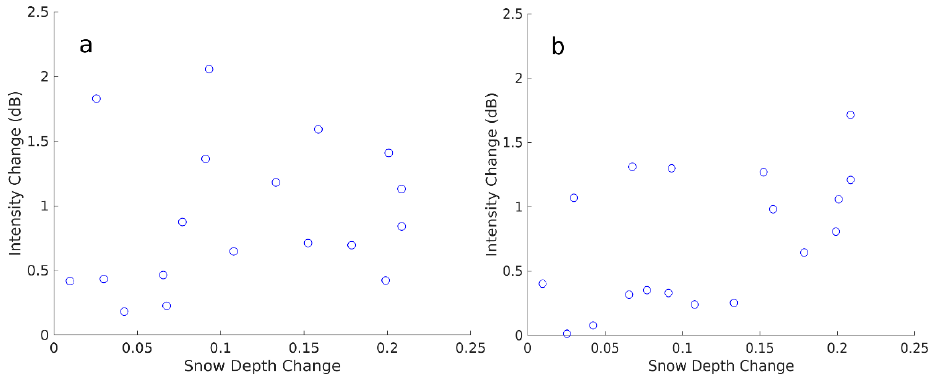
Figure 5. Scatter plot of model intensity changes (dB) versus snow depth changes (meter) for forested ( a ) and shrub ( b ) land cover types.